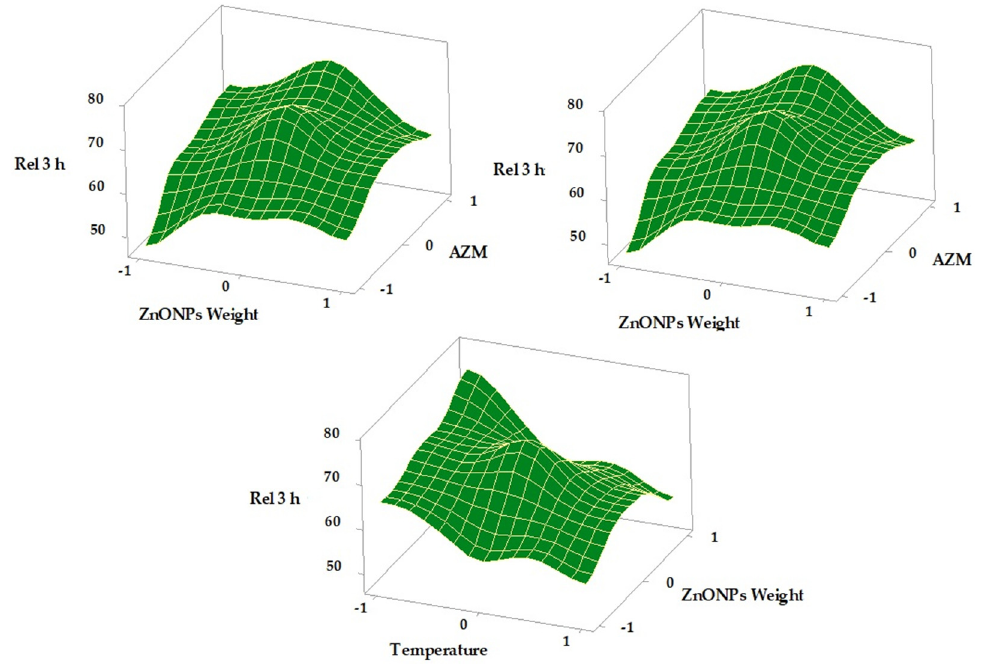
Figure 7. Surface plot effects of different formulation factors on release after 3 h.